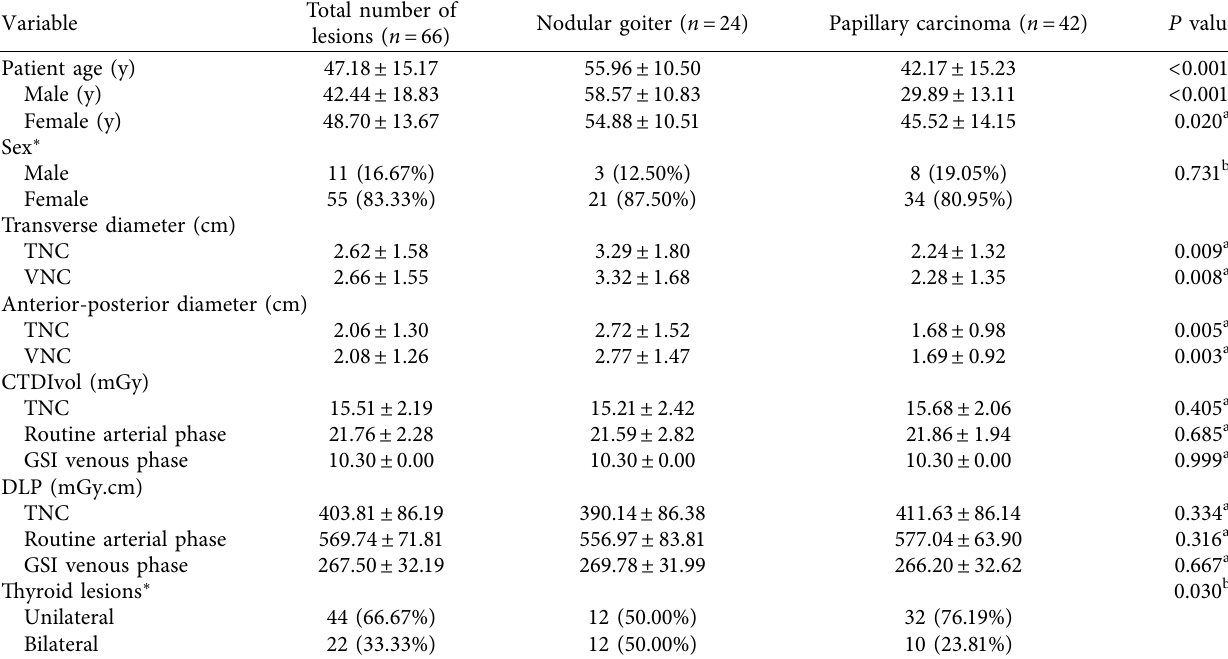
Table 1: Patient characteristics and radiation